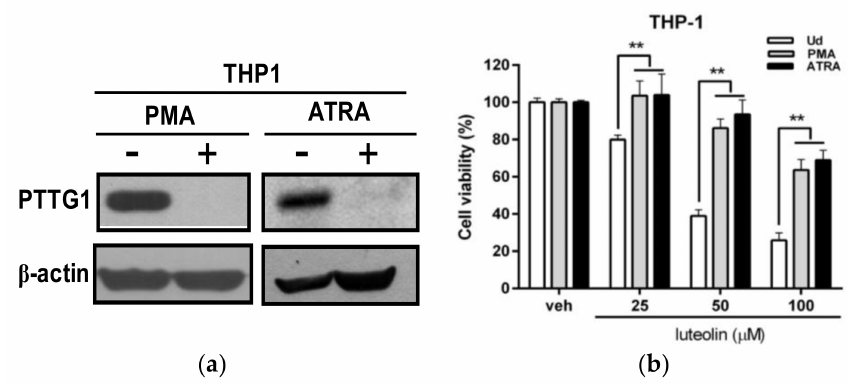
Figure 2. Effects of luteolin on the viability of THP-1 cells with differential pituitary tumor-transforming gene 1 (PTTG1) expression. ( a ) THP-1 cells were pretreated with PMA (200 nM) or ATRA (10 µ M) for 72 h. The levels of PTTG1 and β -actin protein were determined by Western blot analysis. The experiments were performed at three times, and a representative blot is shown. ( b ) THP-1 cells were pretreated with PMA (200 nM) or ATRA (10 µ M) for 72 h differentiation, and then, differentiated THP-1 cells were incubated with vehicle or luteolin (25, 50 and 100 µ M) for 24 h. Cell viability was determined by MTT assay. ** p < 0.01 represents a significant difference compared to the PMA- or ATRA-untreated cells (Ud